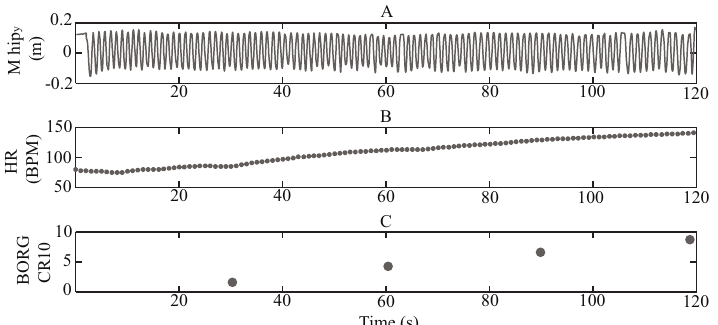
Figure 3. Example data of one volunteer test, ( A ) M_hip vertical signal, ( B ) heart rate signal and ( C ) Borg CR10 values.